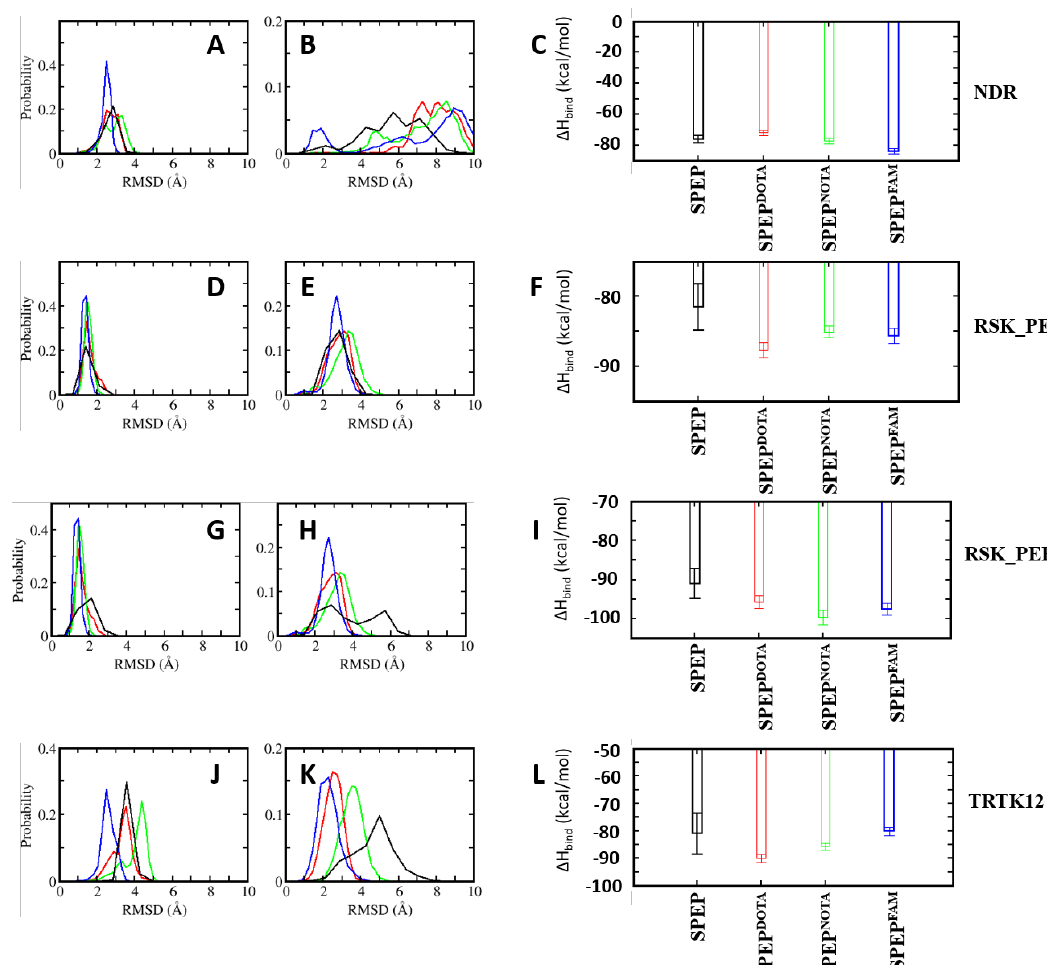
Figure 10. Distribution of root mean squared deviations (RMSD) of ( A , D , G , J ) S100B( ββ ) and ( B , E , H , K ) the bound stapled peptides conjugated with imaging probes (DOTA, NOTA and FAM) (( A , B ): S100B( ββ )–NDR; ( D , E ): S100B( ββ )–RSK_PEP1; ( G , H ): RSK_PEP2; ( J , K ): S100B( ββ )-TRTK12 complexes). Different colours correspond to the stapled peptides with different probes (black: no probe, red: DOTA, green: NOTA and blue: FAM). ( C , F , I , L ) Binding free energies of the interactions of S100B( ββ ) with the stapled peptide probes were calculated with the MMPBSA approach (see Methods) using the conformations sampled during the MD simulations of the S100B( ββ )–stapled peptide probe